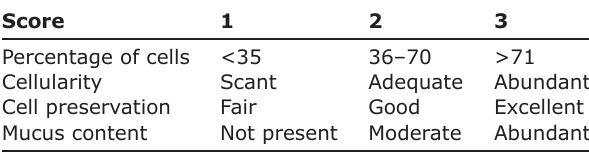
Table-1: Semi-quantitative scoring system to evaluate the cellularity, cell preservation, and mucus content of the